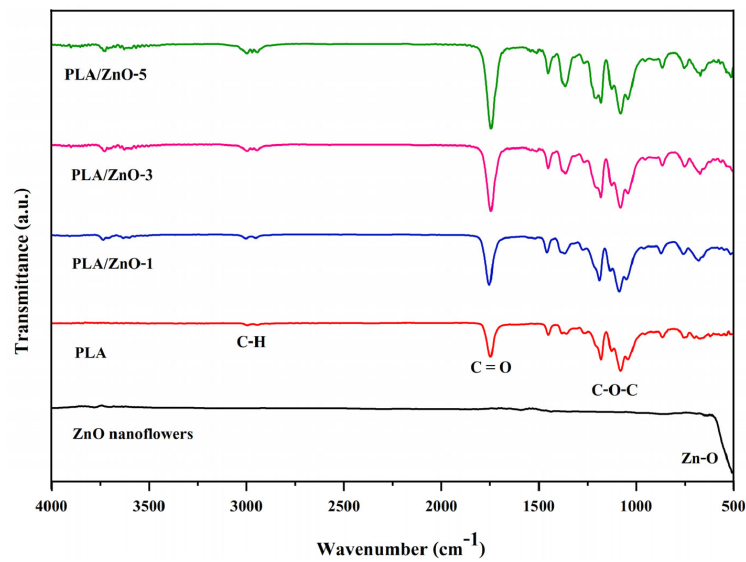
Figure 3. FTIR spectra of ZnO nanoflowers, neat PLA, and PLA/ZnO biocomposite